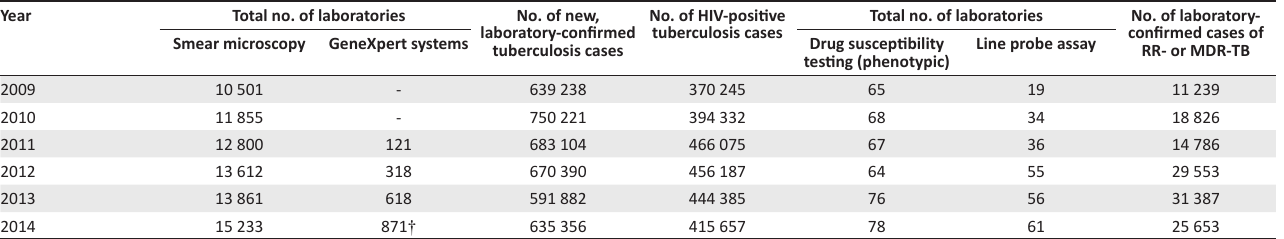
TABLE 3: Tuberculosis laboratory services in Africa, 2009–2014.